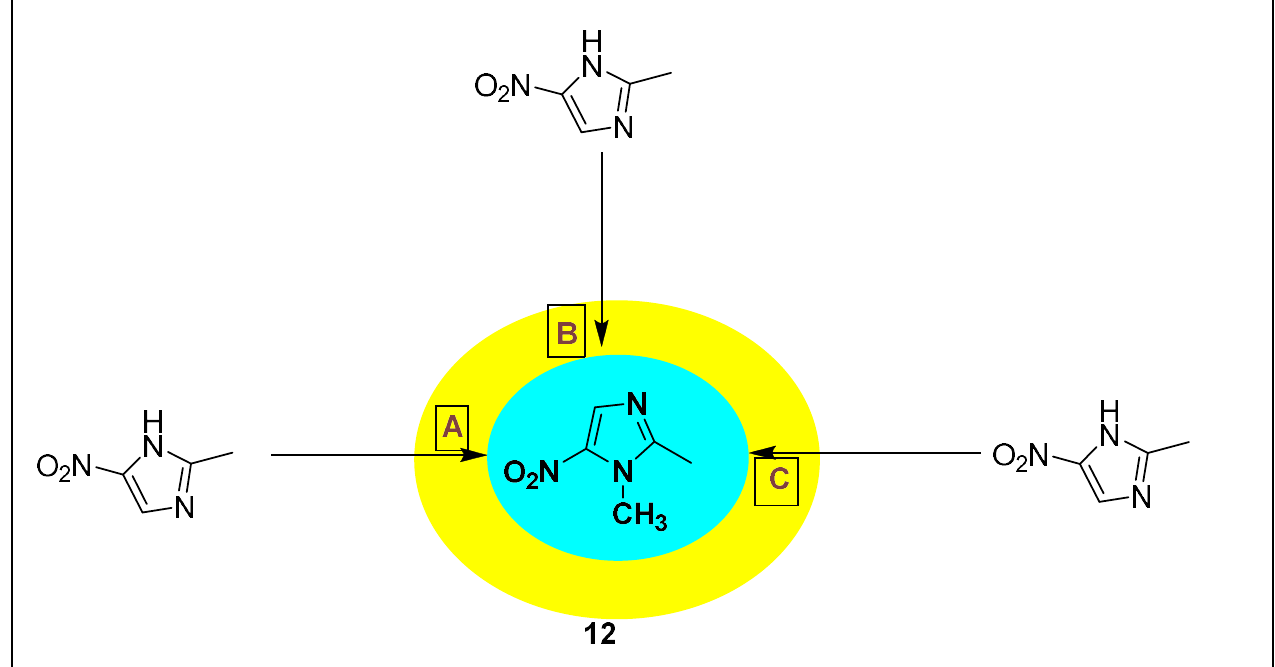
Figure 17. Activity profile of Dimetridazole 13